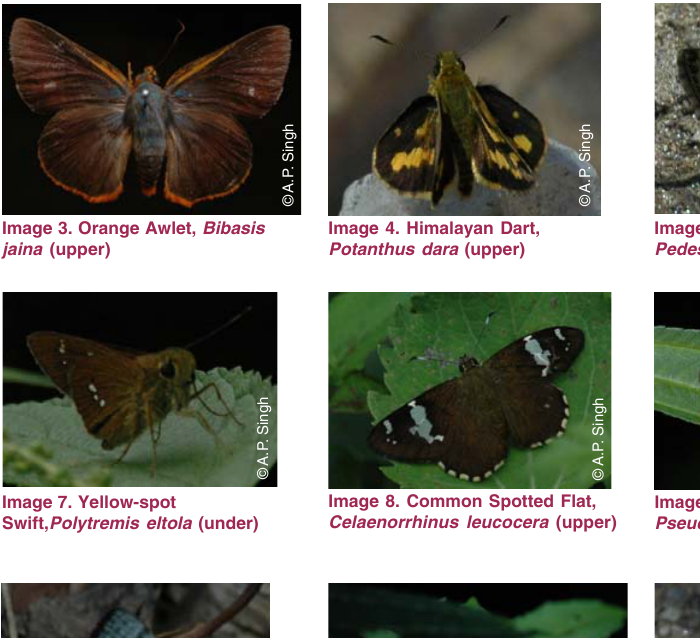
Image 7. Yellow-spot Swift, Polytremis eltola (under)